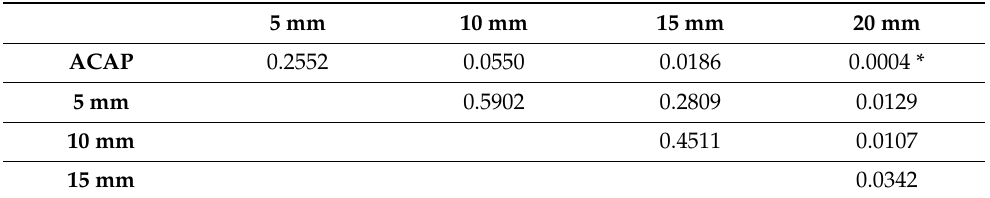
Table 3. Post-hoc test p -values (upper forearm).